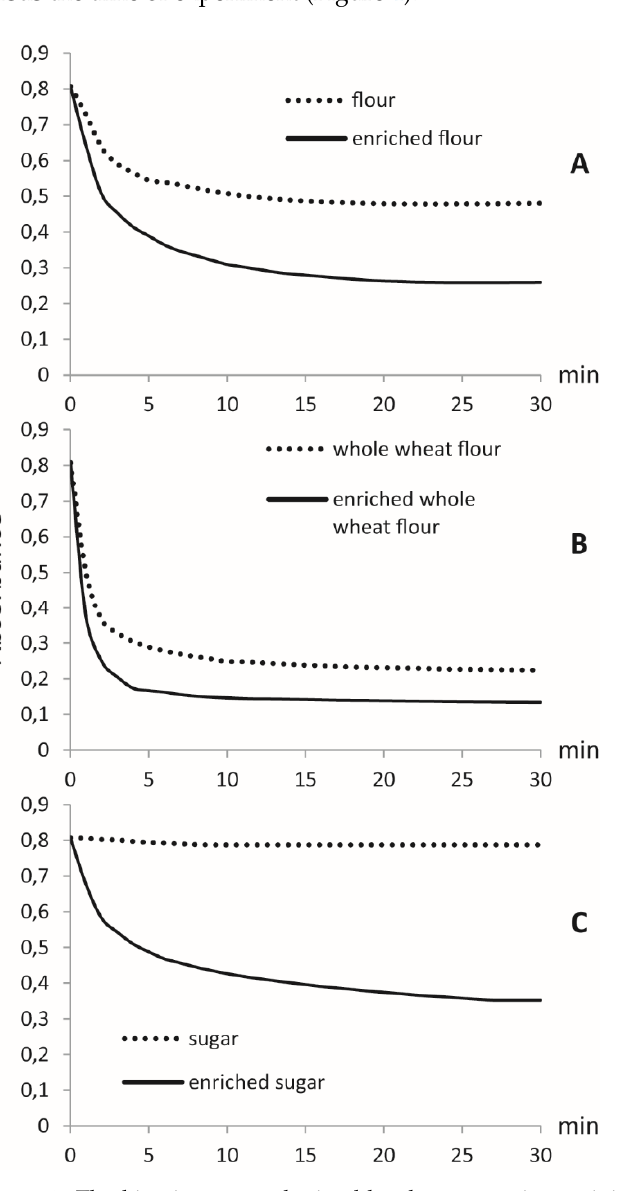
Figure 4. The kinetic curves obtained by the scavenging activity of DPPH performed on foods. ( A ) flour vs. enriched flour. ( B ) whole ‐ wheat flour vs. enriched whole ‐ wheat flour. ( C ) sugar vs. en ‐ ( A ) flour vs. enriched flour. ( B ) whole-wheat flour vs. enriched whole-wheat flour. ( C ) sugar vs. riched sugar. enriched